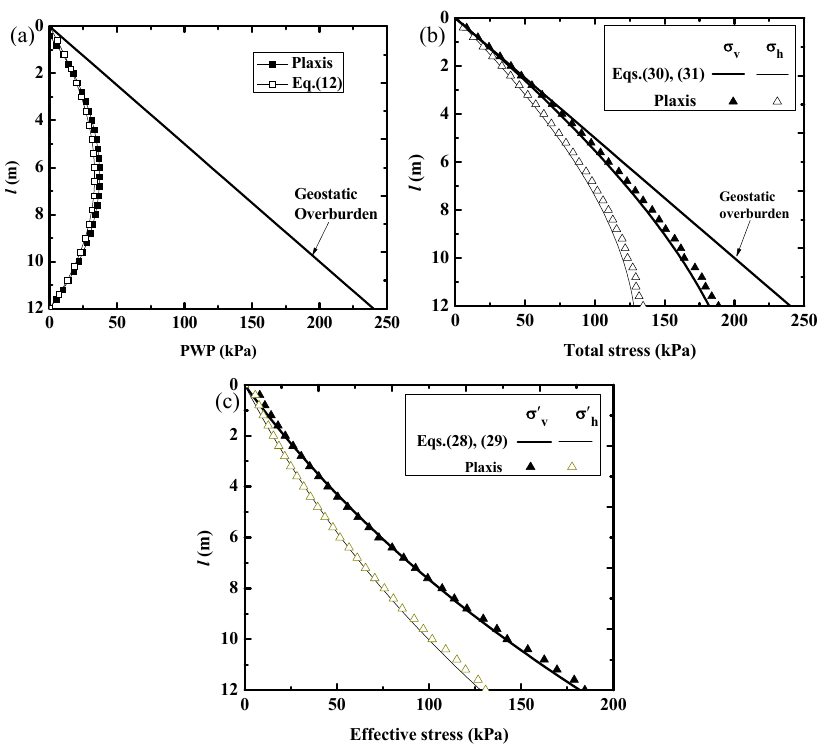
Figure 5. Distribution of the ( a ) (excess) PWP, ( b ) total and ( c ) effective stresses along the VCL at the end of backfill deposition (at t = 24 h and h = H = 12 m), obtained by numerical modeling results performed with Plaxis2D and calculated using the proposed solution (Equations (12), (28)–(31)) by considering K a ; calculations conducted with H = 12 m, B = 4 m, c v = 4 m 2 /h, m = 0.5 m/h, γ = 20 kN/m 3 , γ w = 10 kN/m 3 , and ϕ ’ = 10°.